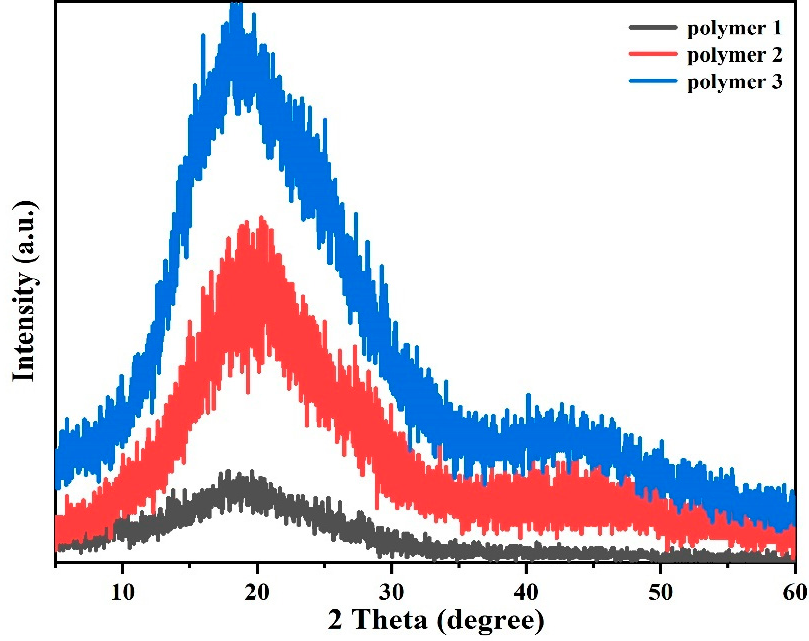
Figure 7. WAXD pattern of DPTP polymers.